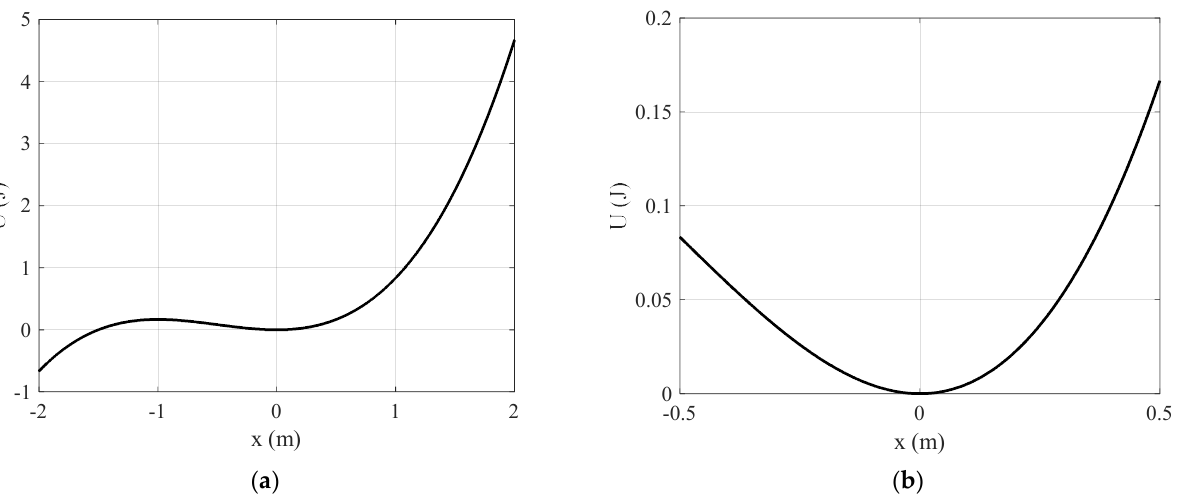
Figure 1. The U = f(x) graph ( a ) for −2 m ≤ x ≤ 2 m and ( b ) for −0.5 m ≤ x ≤ 0.5 m . The graphs Figure 1. The U = f ( x ) graph ( a ) for − 2 m ≤ x ≤ 2 m and ( b ) for − 0.5 m ≤ x ≤ 0.5 m. The graphs were plotted using Equation (11). were plotted using Equation (11).